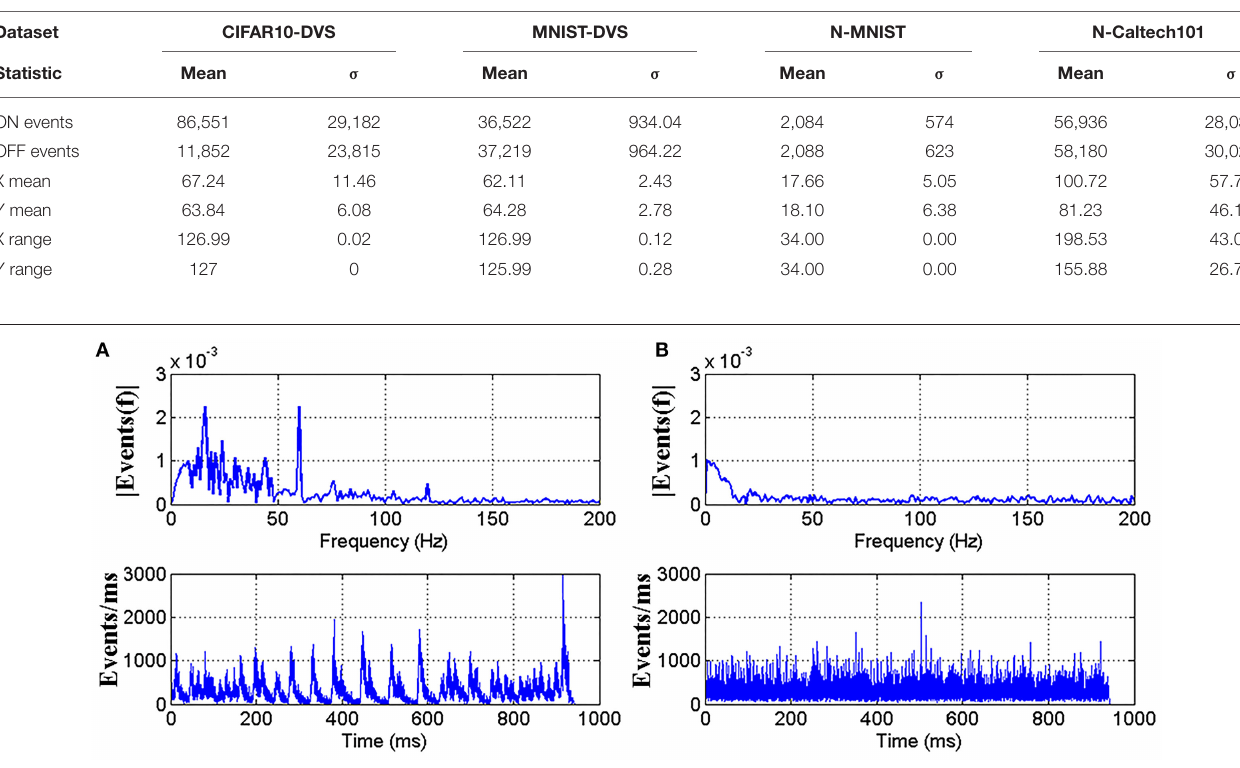
TABLE 3 | Statistical properties of four neuromorphic vision datasets. Dataset